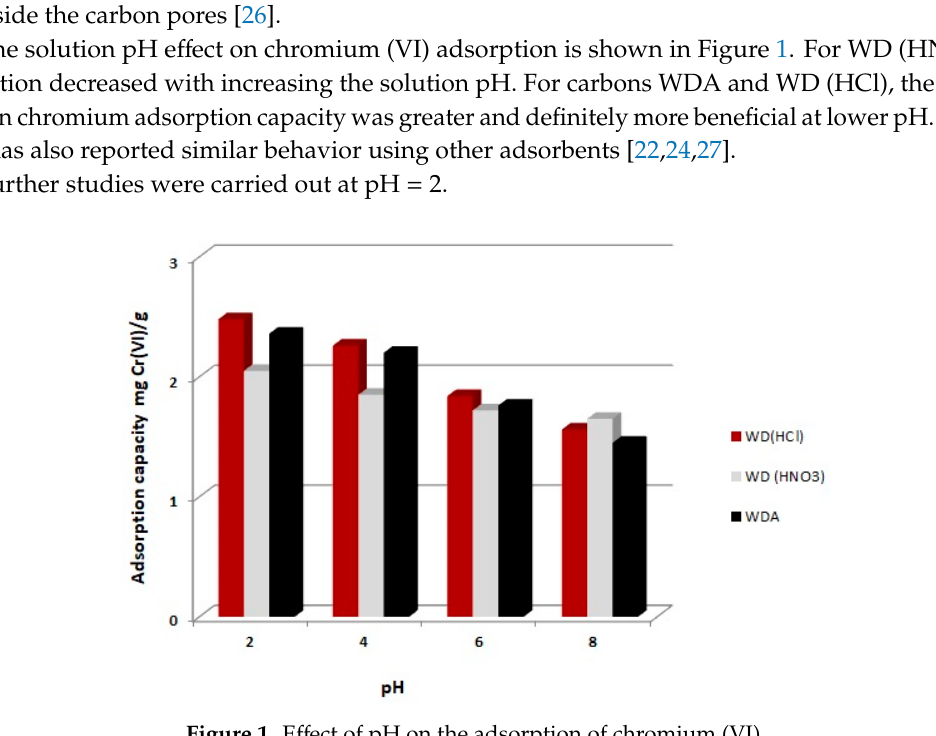
Figure 1. E ff ect of pH on the adsorption of chromium Figure 1. Effect of pH on the adsorption of chromium (VI).